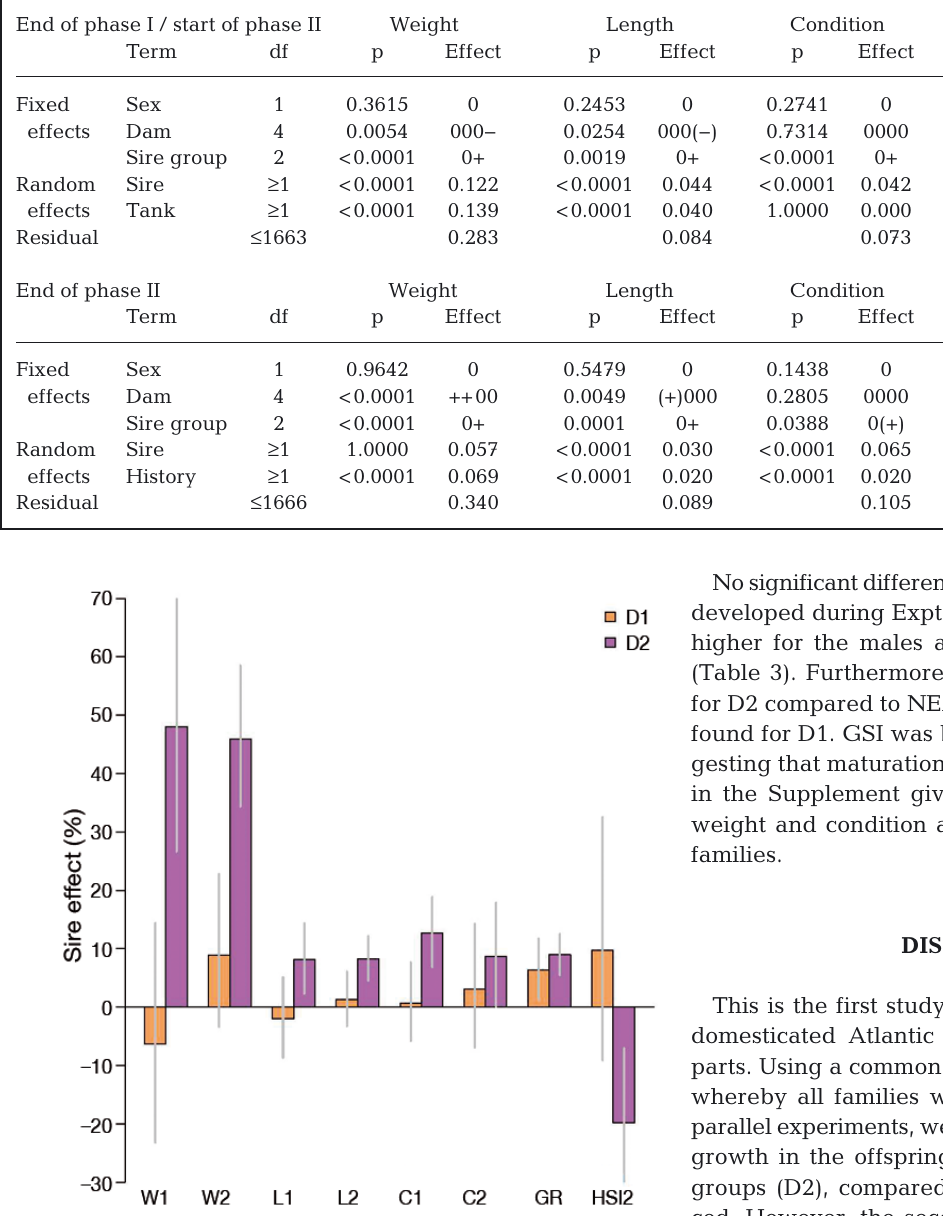
Fig. 5. Modeled effect of cod sire group on different meas- ures taken at the end of Phases I and II in Expt B. The sire effects for broodstock groups D1 and D2 are given as a per- centage relative to the wild Northeast Arctic (NEA) group. Error bars show 95% confidence limits. HSI: hepatosomatic index of Phase II; other parameter codes as in Fig. 3. See Table 3 for further description of modeling results